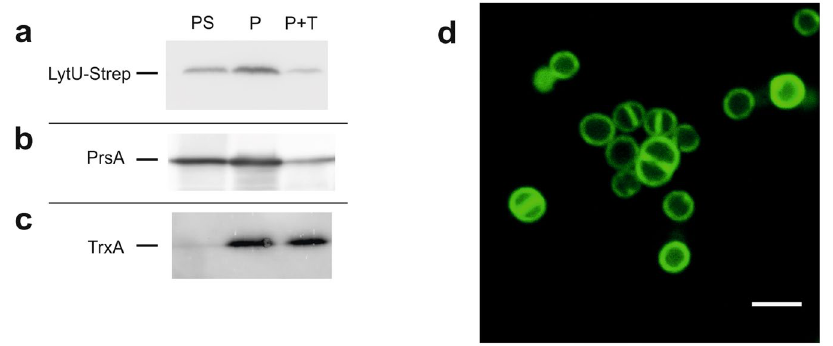
Figure 4. Determination of orientation and localisation of LytU in the plasma membrane. ( a, b, c ) Trypsin treatment of protoplast surface proteins showing that LytU behaves like a protein outside on the plasma membrane surface. The three vertical immunoblotting lanes in the assay correspond to: P , protoplasts; PS , protoplast supernatant; P + T , protoplasts treated with 1 mg ml -1 trypsin. As the level of production from the used expression vector is controlled by the amount of xylose inducer, 0.02% xylose was used to get very low amounts of LytU, resembling the natural conditions. The controls are shown in Supplementary Fig. S1. ( d ) Confocal microscopy image of S. aureus cells showing fluorescence of the N-terminal GFP-fusion to LytU protein. Scale bar, 2 μ m. Clear localization of the fusion protein in the plasma membrane is seen as well as some possible accumulation at cell division sites (see text and Methods for